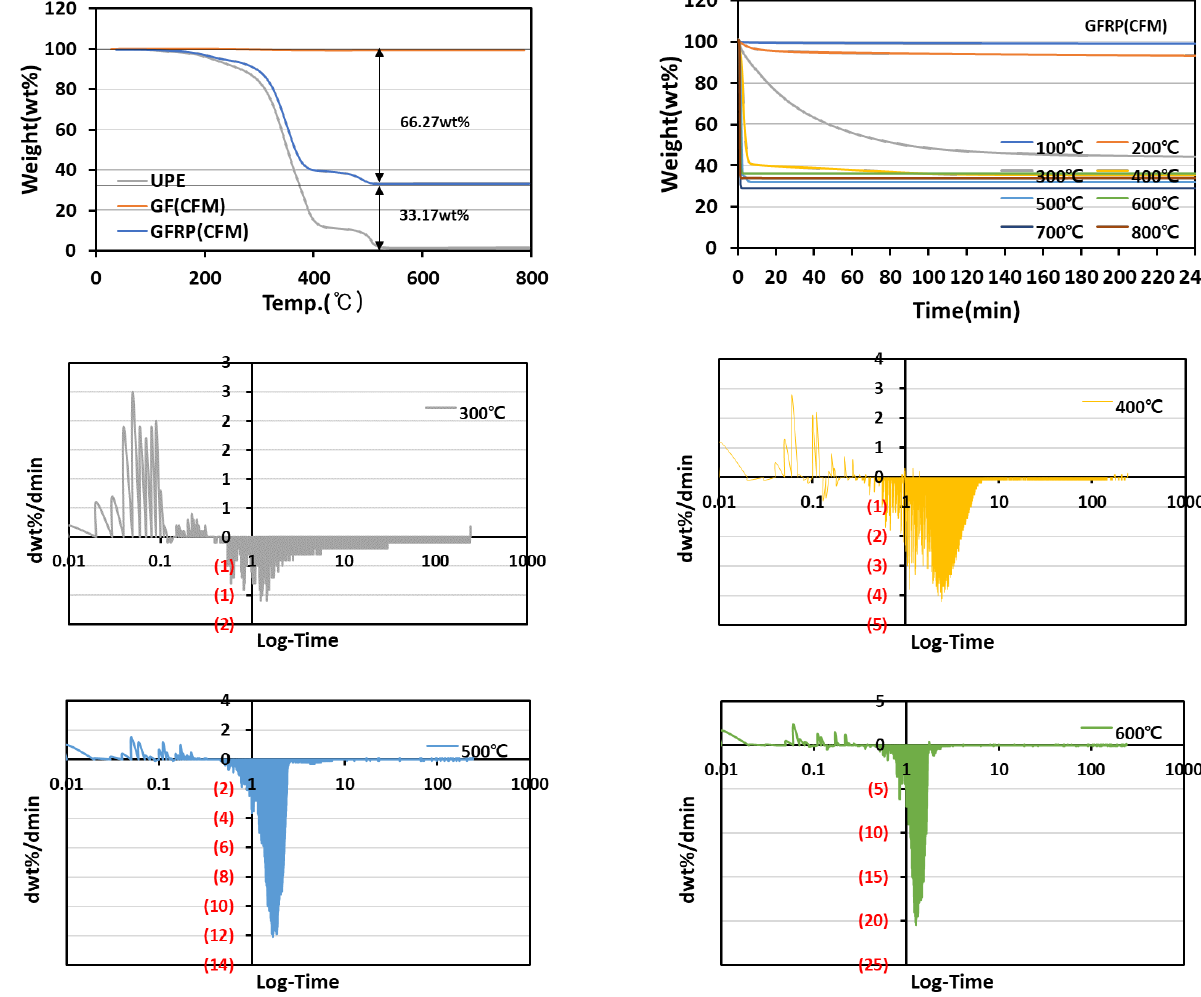
Figure 4. GFRP (CFM) weight change and heat treatment time according to pyrolysis